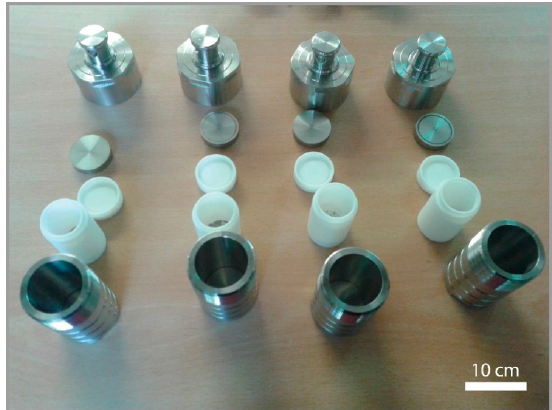
Figure 2. Teflon vessel and reactor for hydrothermal synthesis used in the laboratory experiment.